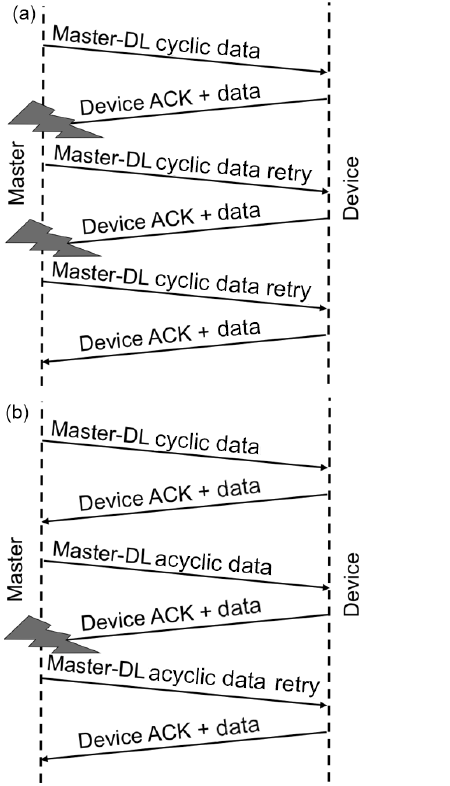
Figure 7. Data transfer errors. (a) Worst-case scenario: double error occurring in cyclic data exchange. (b) Error occurring in acyclic data